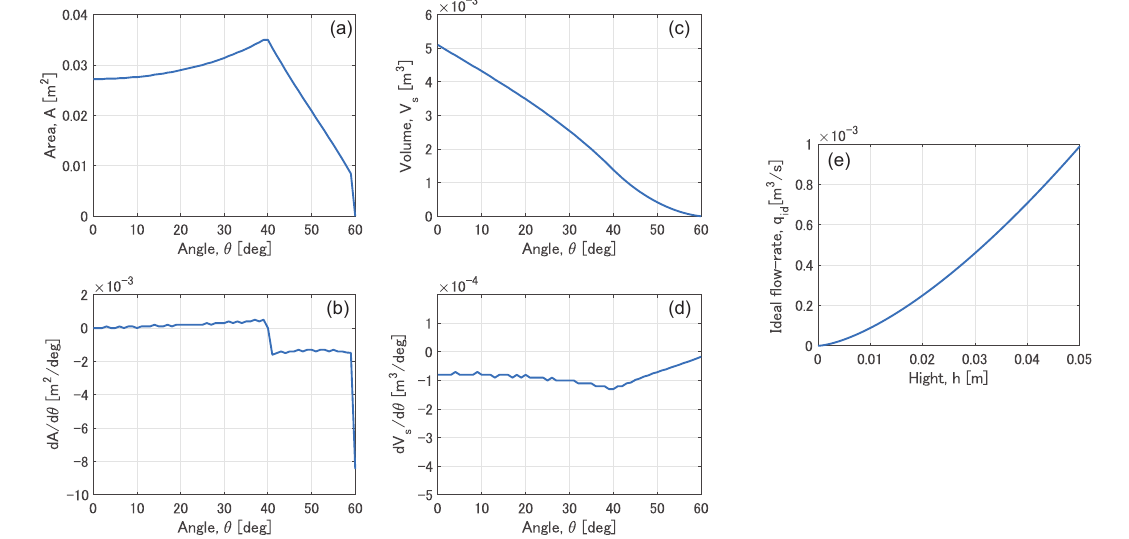
Figure 8. Model parameters related to the ladle shape. ( a ) Area of liquid plane which is horizontally located on the pouring mouth, A ( θ ) . ( b ) Partial derivative of the area A ( θ ) , with respect to the angle θ . ( c ) Liquid volume under the tip of the pouring mouth, V s ( θ ) . ( d ) Partial derivative of area V s ( θ ) , with respect to the angle θ . ( e ) Ideal flow rate q id of the outflow liquid, with respect to the liquid height h at the pouring